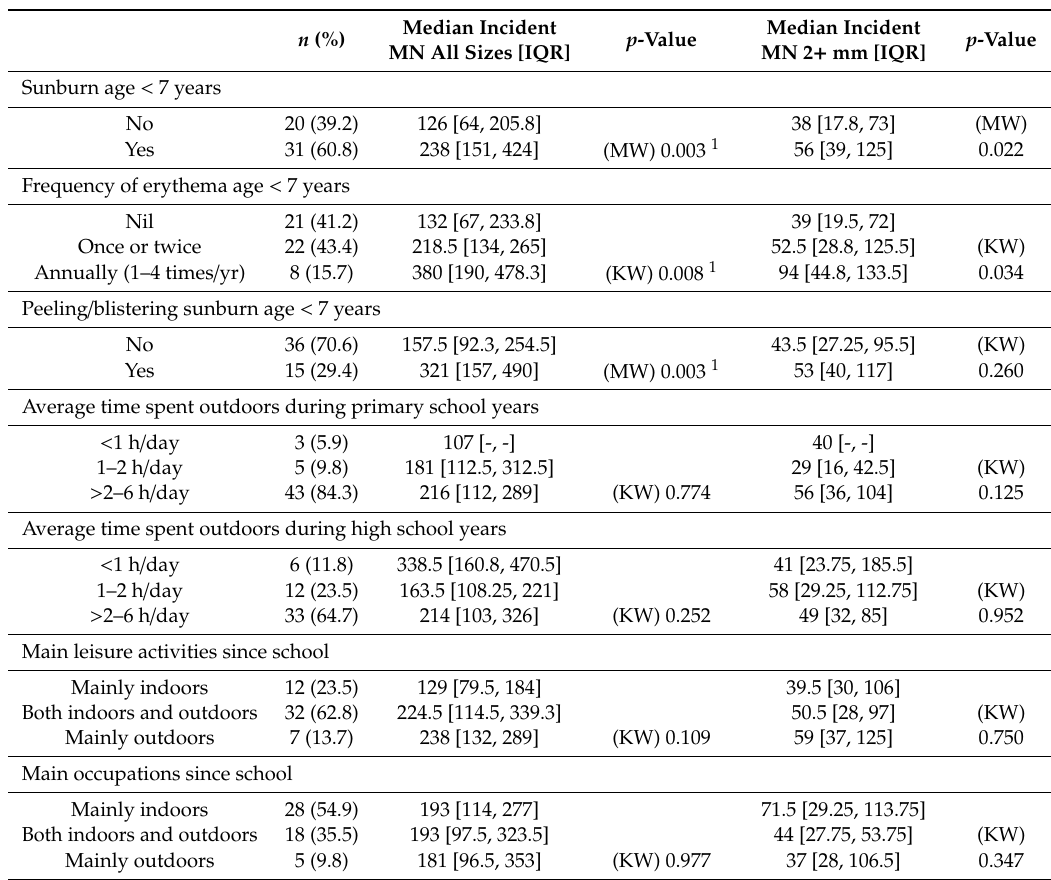
Table 4. Median incident melanocytic nevi (MN) and median incident MN ≥ 2 mm by sun-exposure